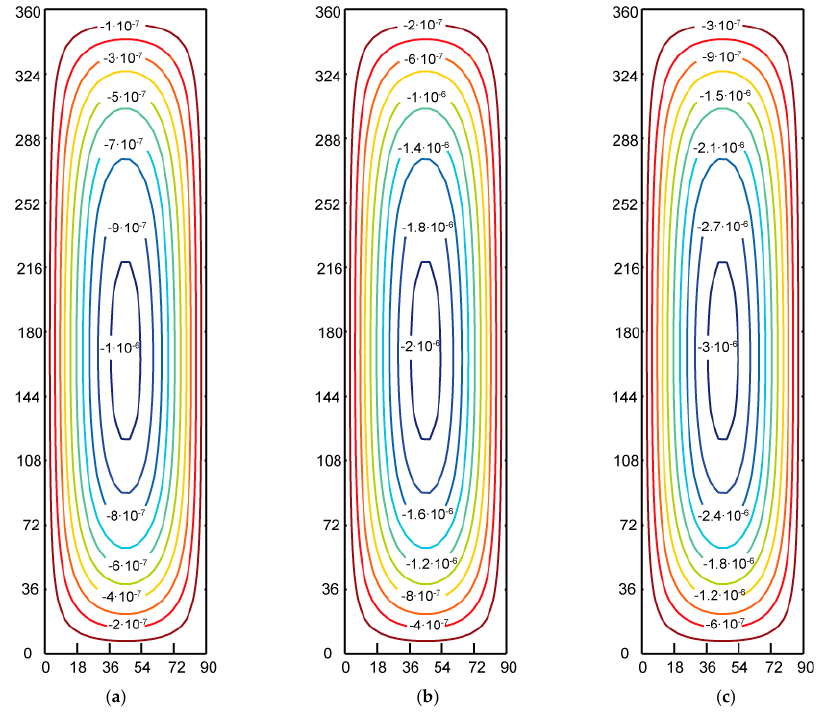
Figure 4. Steady state streamfunction patterns for the first application (Ra = 200): ( a ) Case 1; ( b ) Case 2; and ( c ) Case 3.